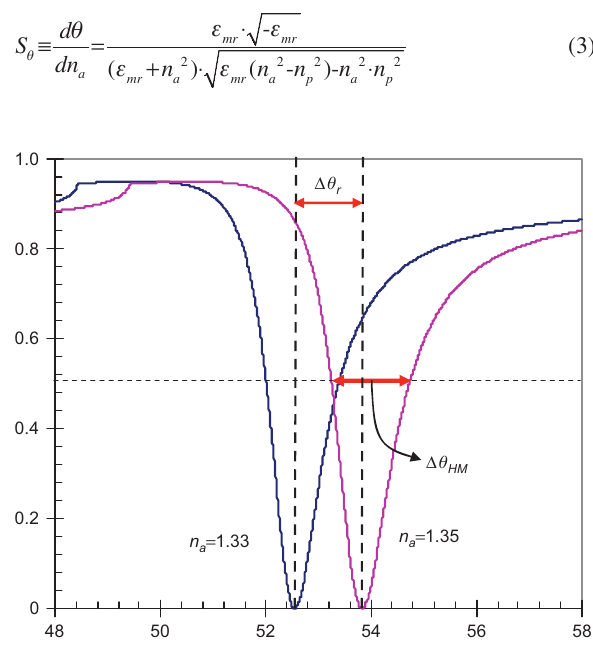
Figure 3 Change in surface plasmon resonance signal due to a change in the analyte refractive index: n